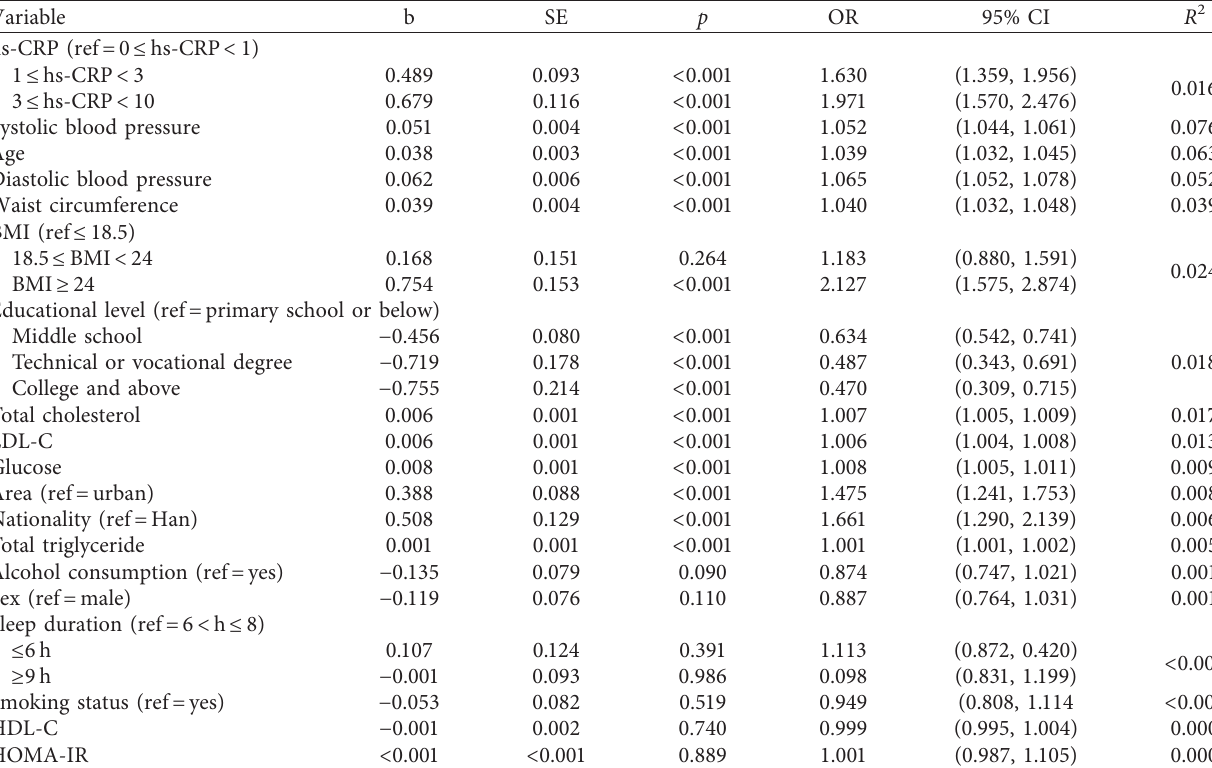
Table 3: Univariate analysis of the incidence of hypertension and its contribution.